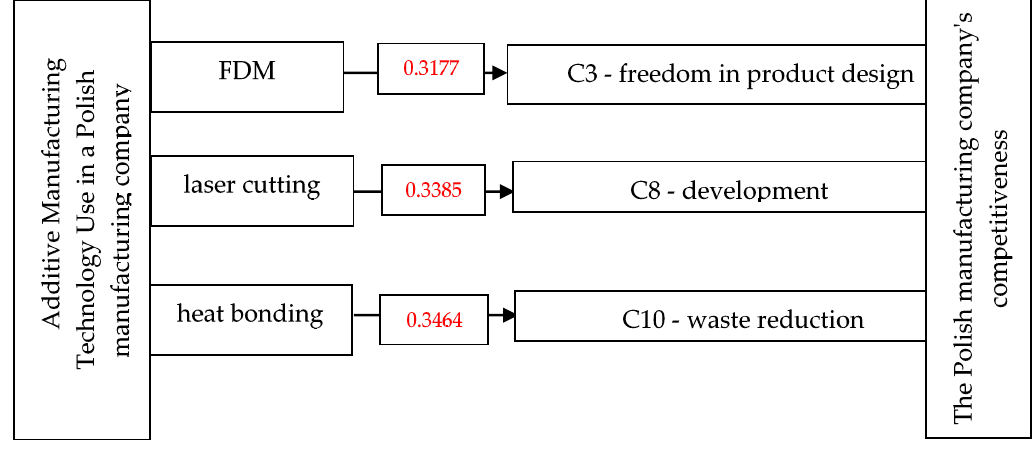
Figure 10. The structural model.